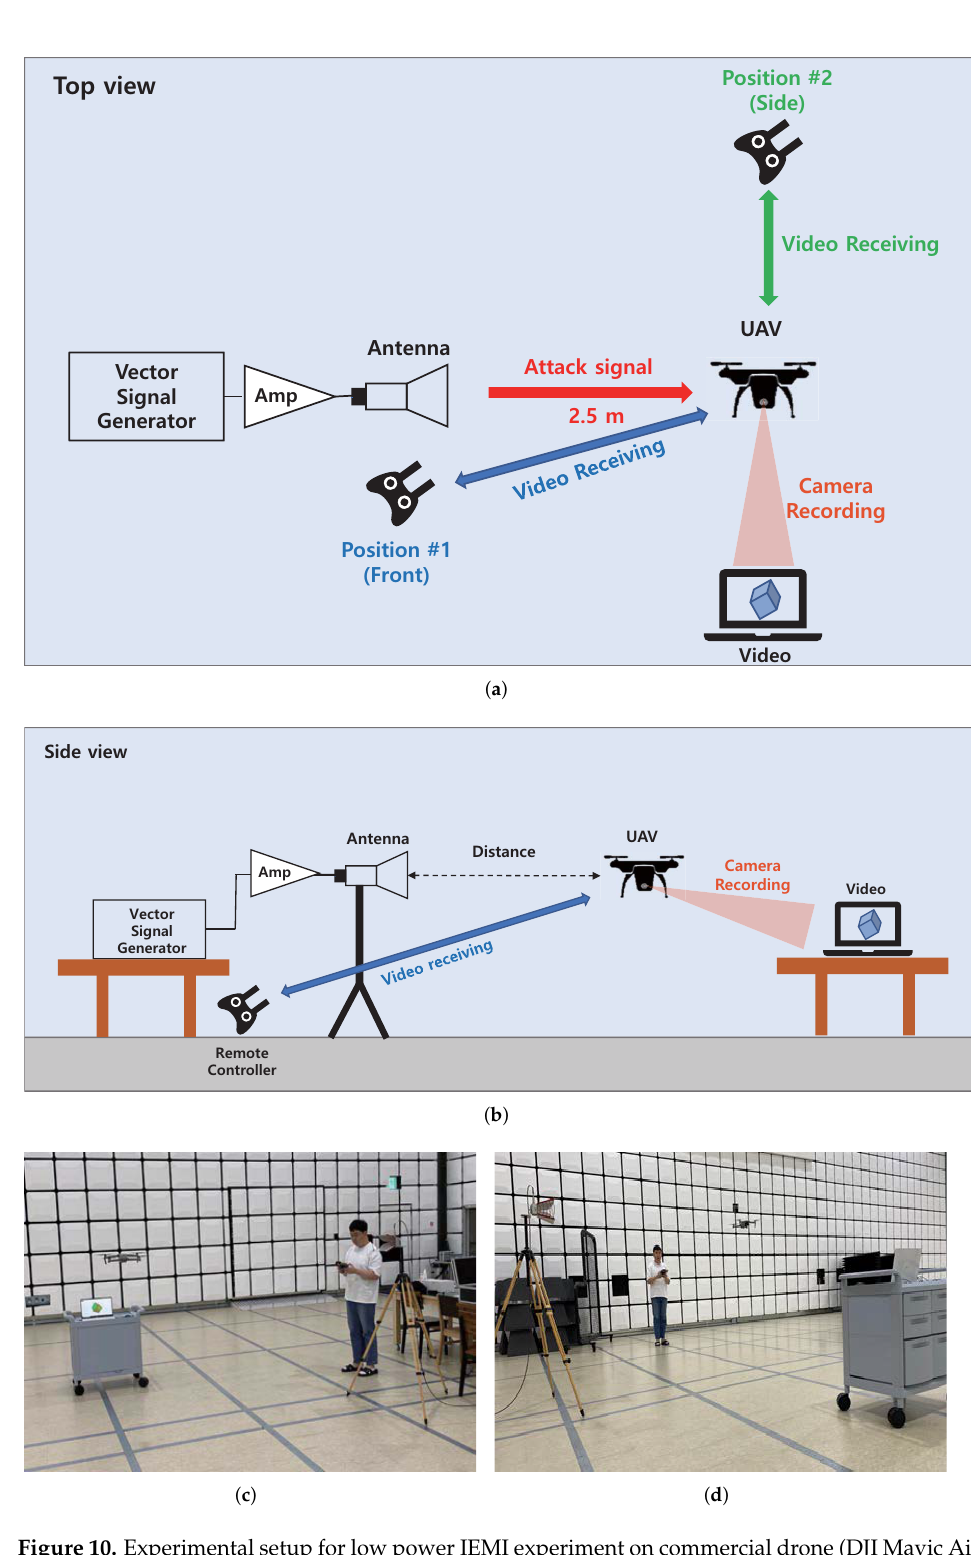
Figure 10. Experimental setup for low power IEMI experiment on commercial drone (DJI Mavic Air2). ( a ) Experimental setup diagram (Top view); ( b ) Experimental setup diagram (Side view); ( c ) Realized experimental setup (Front); ( d ) Realized experimental setup